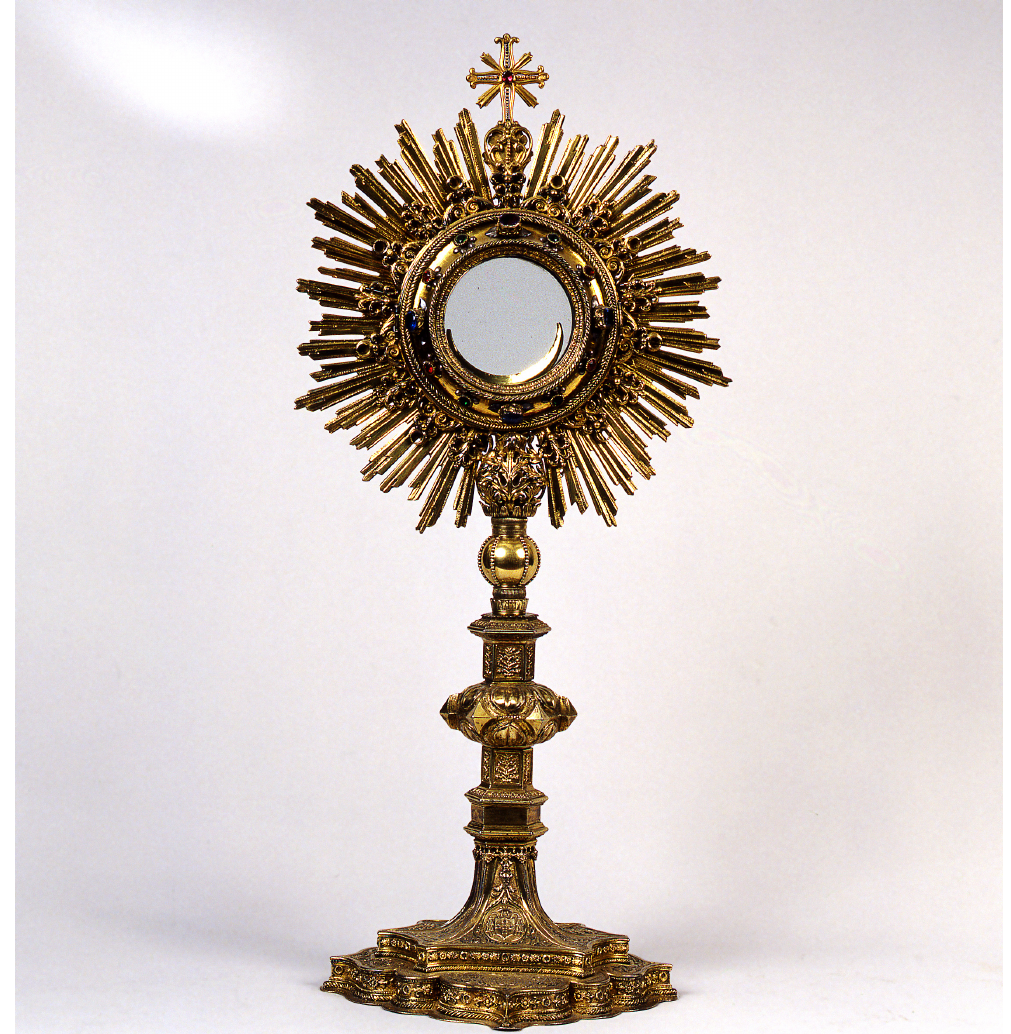
Figure 1. Ostensory, Roman workshop, ca. 1468, gilded silver, height 56 cm, Museo dell’Opera del Duomo, Siena (photo: Opera della Metropolitana di Siena).